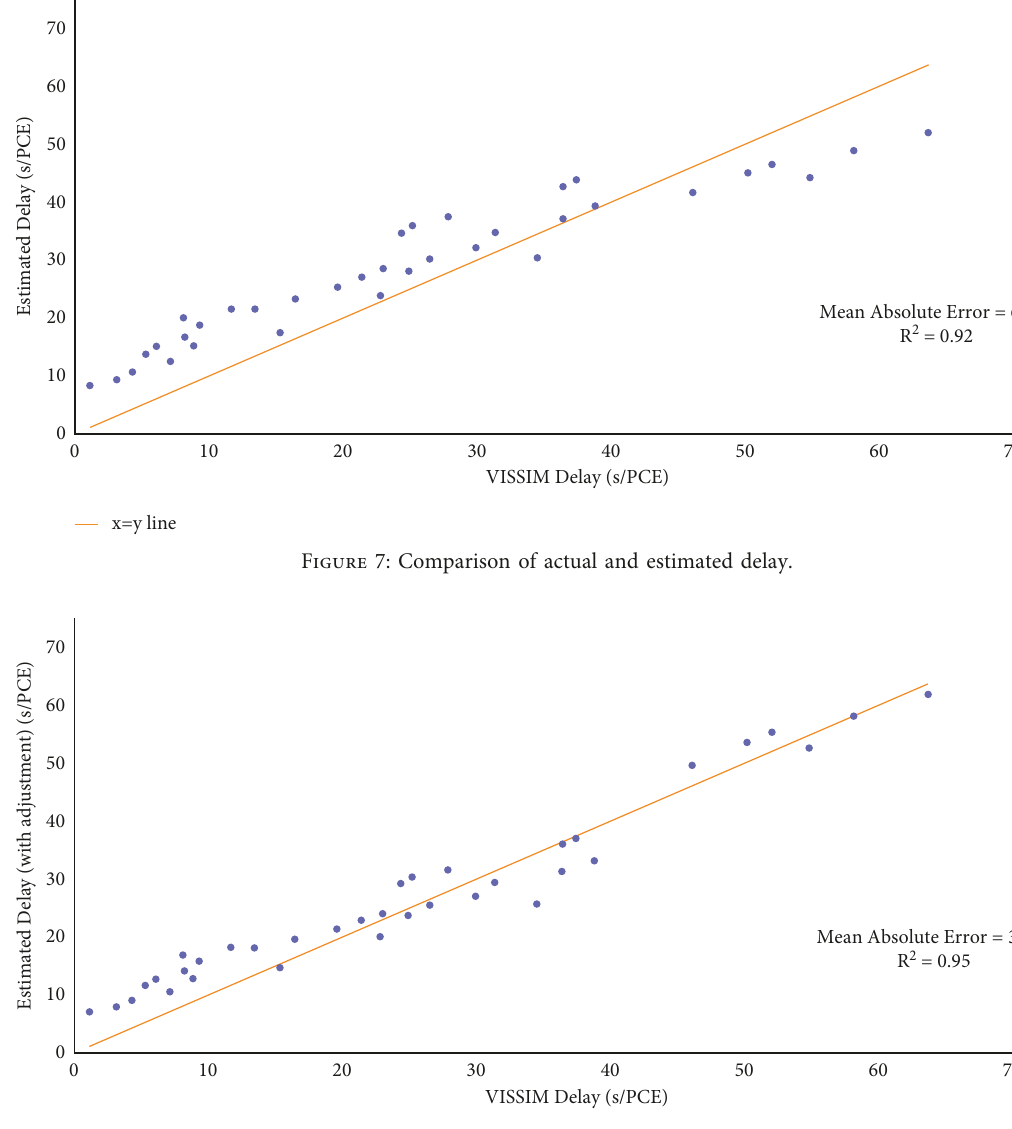
Figure 8: Comparison of actual and estimated delay with multiplicative adjustment factor.